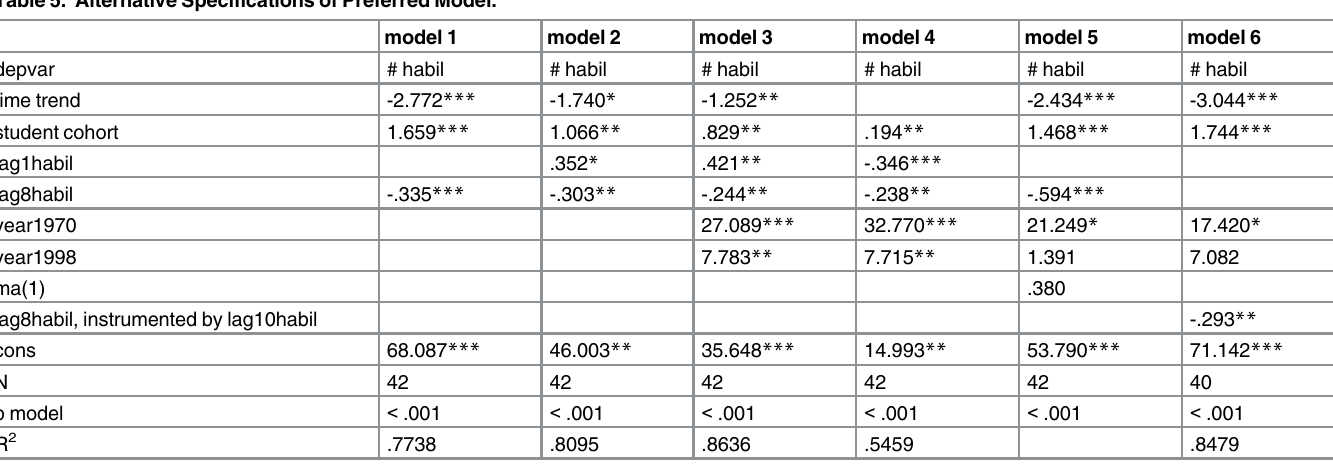
Table 5. Alternative Specifications of Preferred